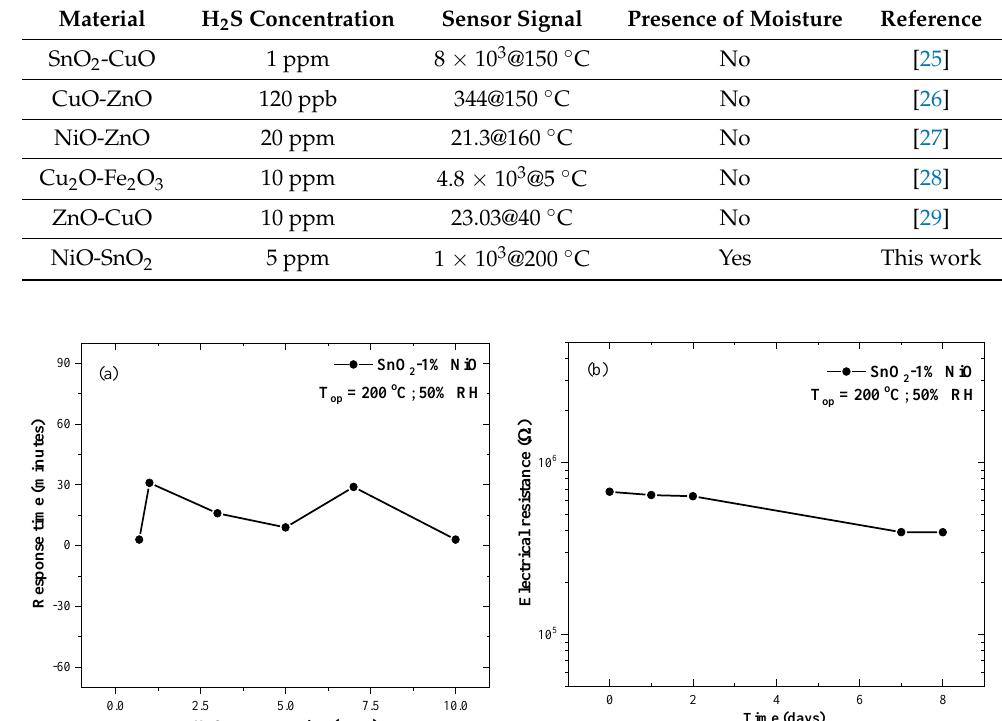
Figure 12. Response time with respect to the H 2 S concentration ( a ) and base line electrical resistance stability of SnO 2 -1%NiO operated at 200 °C under 50% RH ( b ).